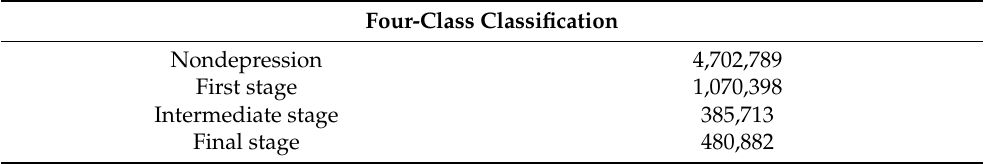
Table 16. The number of feature vectors used as the training data of each class in the four-class